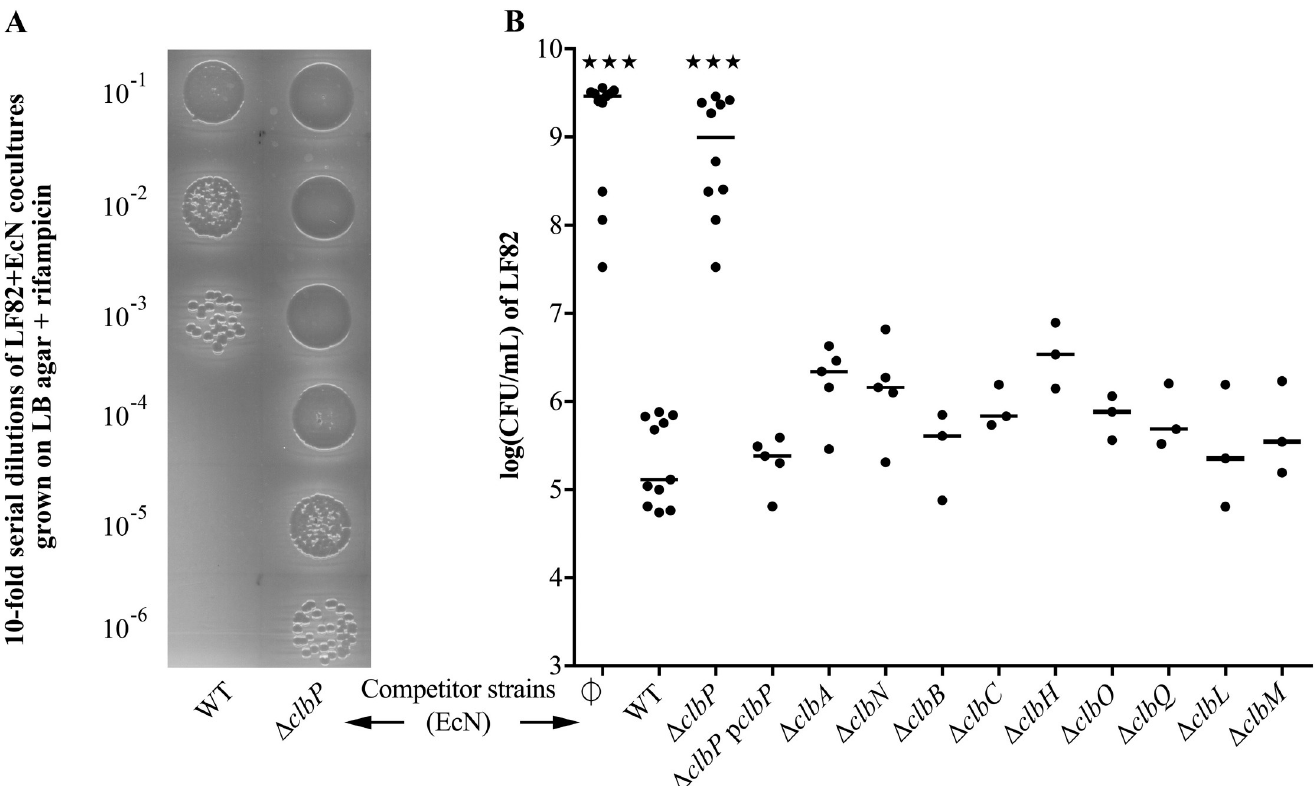
Fig 1. Role of the pks / clb island in EcN antibacterial activity on LF82. ( A) Serial dilutions (ten-fold) of 24-hour co-cultures of E . coli LF82 (rifampicin resistant) with wild-type (WT) E . coli strain Nissle 1917 (EcN) or the mutant for the colibactin maturing peptidase ClbP, spotted (10 μ L) on LB plate containing rifampicin and incubated overnight at 37˚C. Colony forming unit (CFU) counts enable to determine LF82 growth following the 24-hour co-culture. (B) CFU counts of E . coli LF82 following a 24-hour co-culture in M63 medium with WT EcN, gene deletion for the phosphopantetheinyl transferase ClbA, the peptidase ClbP and the corresponding complemented mutant (pclbP), the polyketide synthases (PKS) ClbC and ClbO, the nonribosomal peptide synthases (NRPS) ClbH and ClbN, the hybrid PKS-NRPS ClbB, the putative amidase ClbL, the efflux pump ClbM, and the thioesterase ClbQ. LF82 was also cultured alone as a control ( ∅ ). The medians and individual results of independent experiments are shown. One-way ANOVA and Bonferroni post-tests in comparison with co-culture with WT; $$$ P < 0.001.